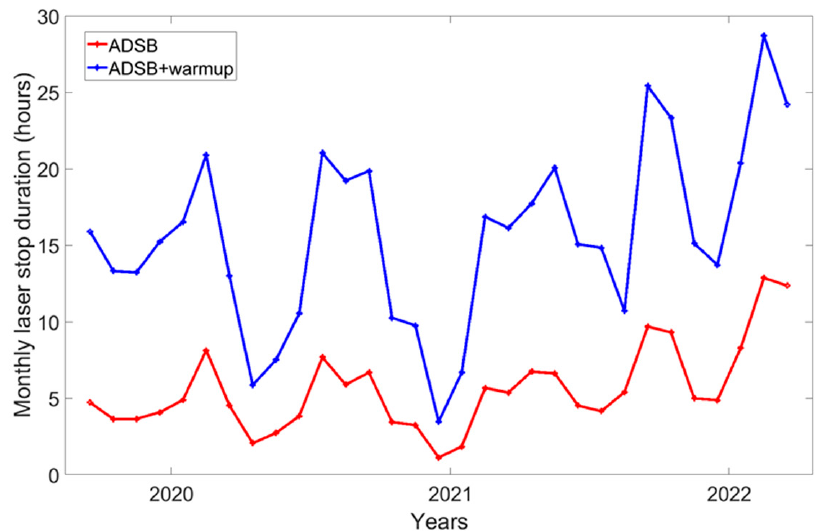
Figure 5. Monthly laser stop and measurement durations. The red line corresponds to the monthly laser stop duration, and the blue line to the measurement stop duration, also including the tempo- rization and warmup time needed to stabilize the laser emission.